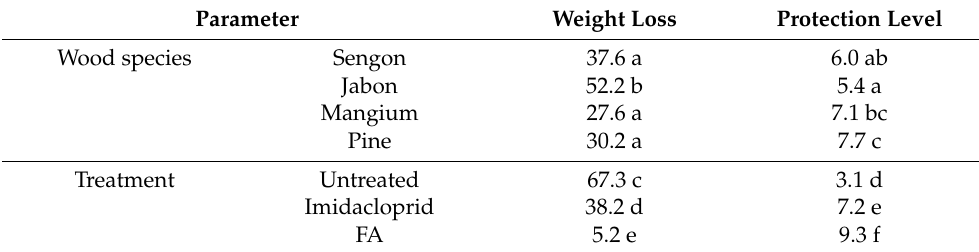
Table 12. Duncan’s multiple range test of percent weight loss and protection level based on wood species and